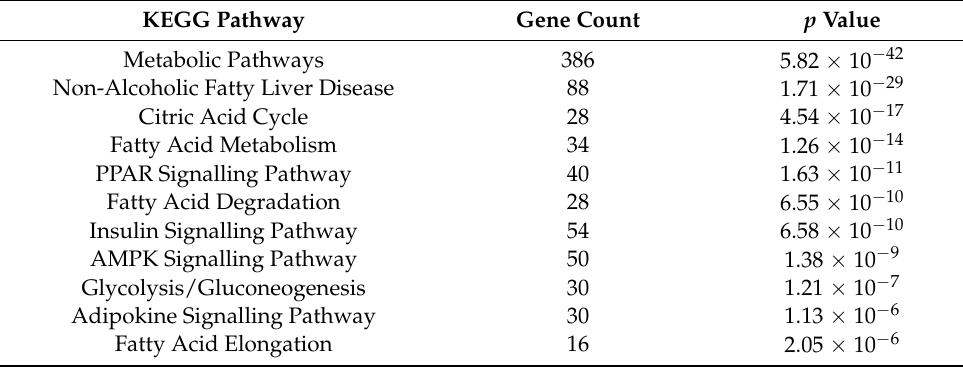
Table 2. Pathway enrichment analysis of downregulated genes from RNAseq analysis of 12-week-old Mmtv-Ccl2 transgenic mouse mammary